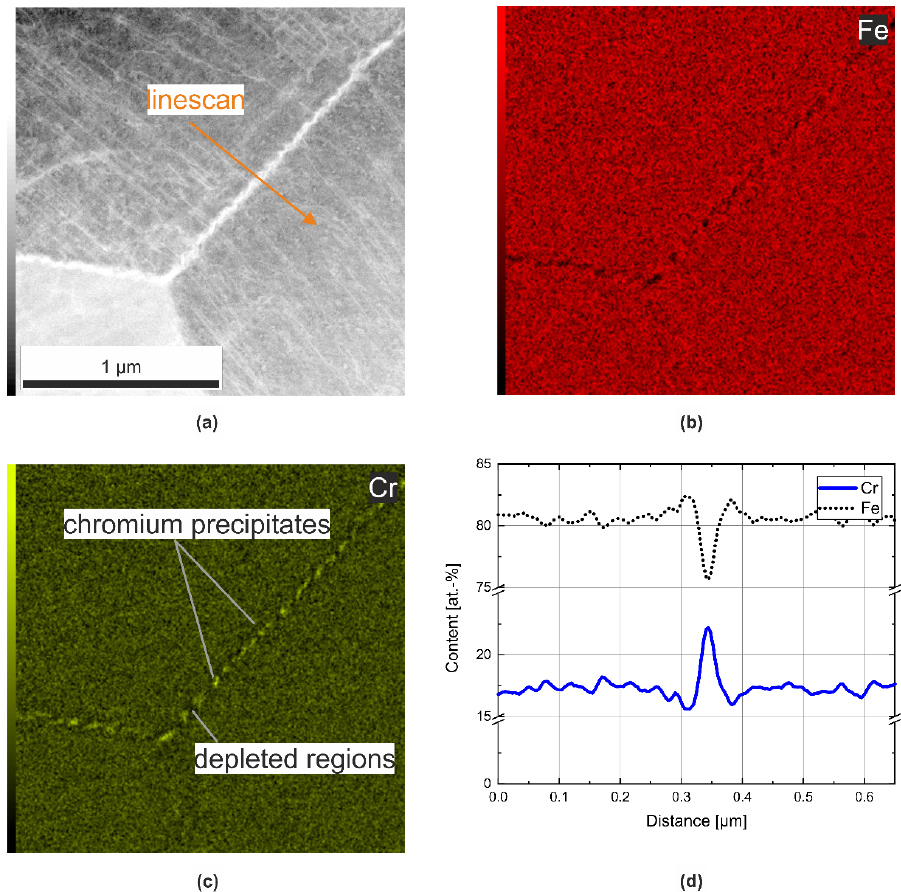
quantified linescan. The corresponding EDS-maps in Figure 3b,c shed light on the precip- itation characteristics during laser-welding.